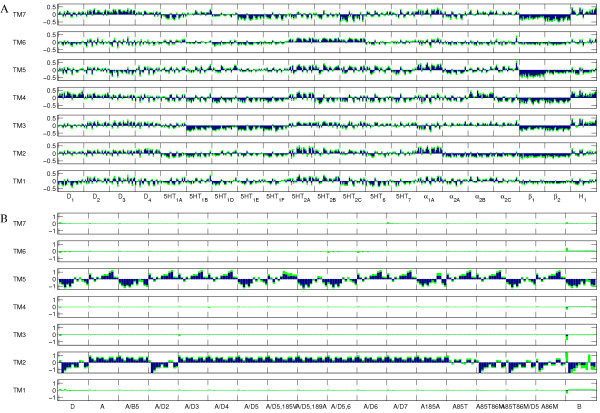
Detailed contributions to affinity. A Contributions of TM regions in amine GPCRs to the ligand affinity according to the proteochemometrics models created using PLS in combination with the variable selection method PLSfilter. The contributions are shown for all the 21 receptors, for each receptor 23 bars corresponding to the 23 ligands are shown (in alphabetical order i.e., Amperozide, Clozapine, Fluparoxan, Fluspirilene, GGR218231, Haloperidol, L741626, MDL100,907, ORG5222, Ocaperidone, Olanzapine, Pipamperone, Raclopride, Risperidone, S16924, S18327, S33084, Seroquel, Sertindole, Tiospirone, Yohimbine, Ziprasidone, Zotepine). The blue bars show the average contribution and the height of the green bars show one standard deviation. The average value and standard deviation were computed using all the 500 models designed (100 repeats and five blocks for each repeat). B Contributions of TM regions in α1-adrenoreceptors to the ligand affinity according to the proteochemometrics models created using RR in combination with the variable selection method PLSfilter. The contributions are shown for all the 18 receptors, for each receptor 12 bars corresponding to the 12 ligands are shown (in numerical order 1–12). The blue bars show the average contribution and the height of the green bars show one standard deviation. The average value and standard deviation were computed using all the 500 models (100 repeats and five blocks for each repeat).